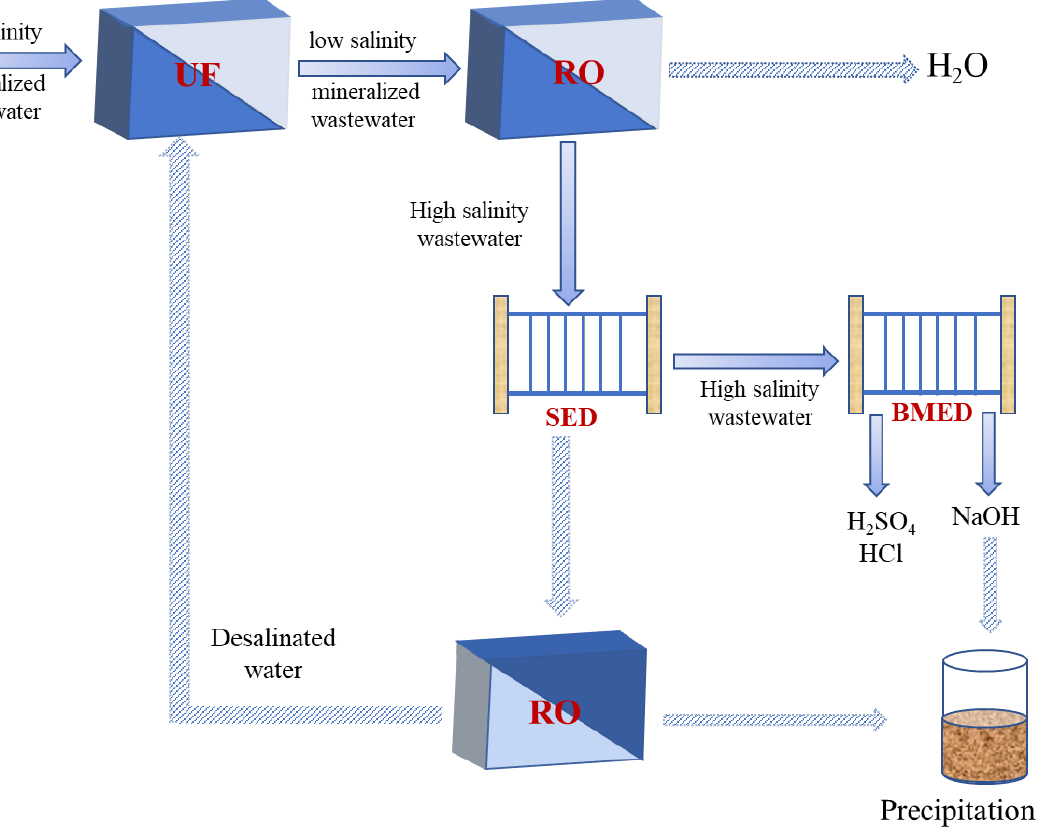
Figure 1. Schematic diagram for zero liquid discharge and resource treatment of low-salinity mineralized wastewater.